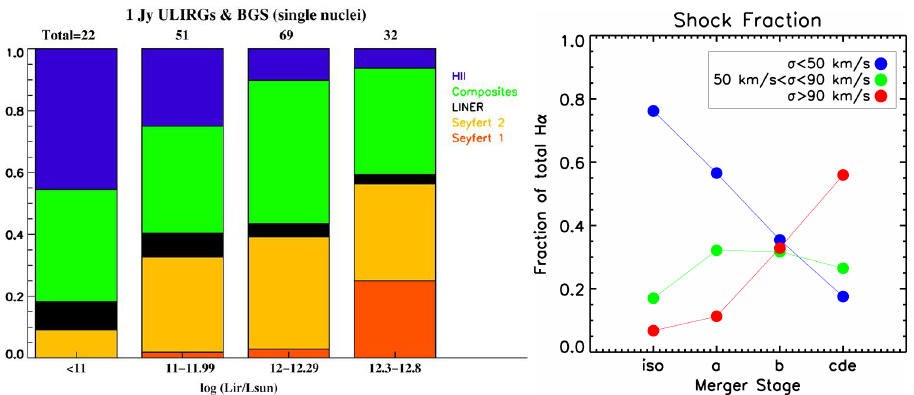
Figure 5. ( Left ) BPT classification of the spectral type as a function of infrared luminosity for (U)LIRG samples from Veilleux et al. [84,85]. Seyfert nuclei dominate over H II regions as L IR increases. Figure from Yuan et al. [86]. ( Right ) The contribution from shocks to the H α luminosity is plotted against the merger stage, from isolated galaxies to early-stage and late-stage mergers. The data points are color-coded by the H α velocity dispersion, where the dispersion cutoffs correspond to H II region velocity dispersions on the low end, and more turbulent and shock-dominated dispersions on the high end. The figure from Rich et al. [89]. Both panels © AAS, reproduced with